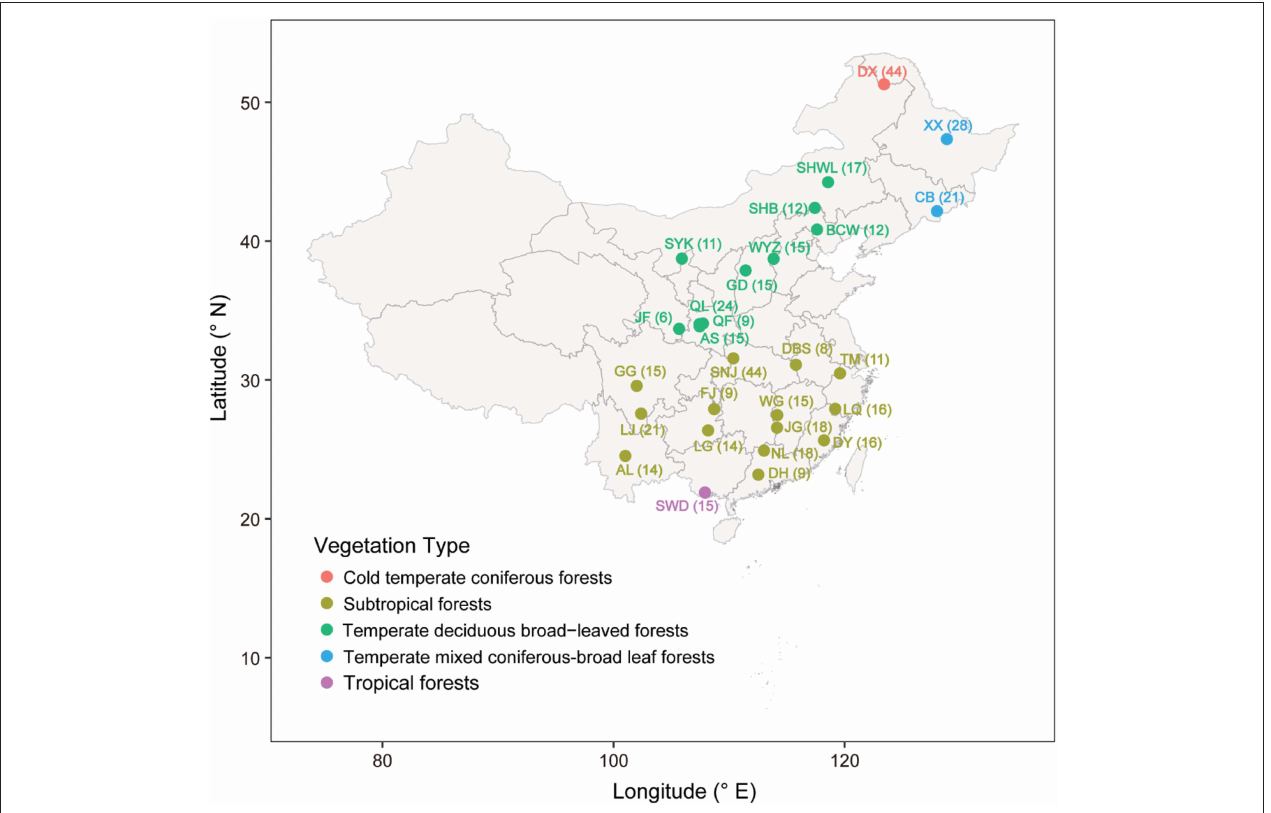
FIGURE 1 | Map of sampling sites, points indicate the positions of forest reserves. The point colors indicate different vegetation types. The name and sample number of each forest reserve were labeled beside the point.